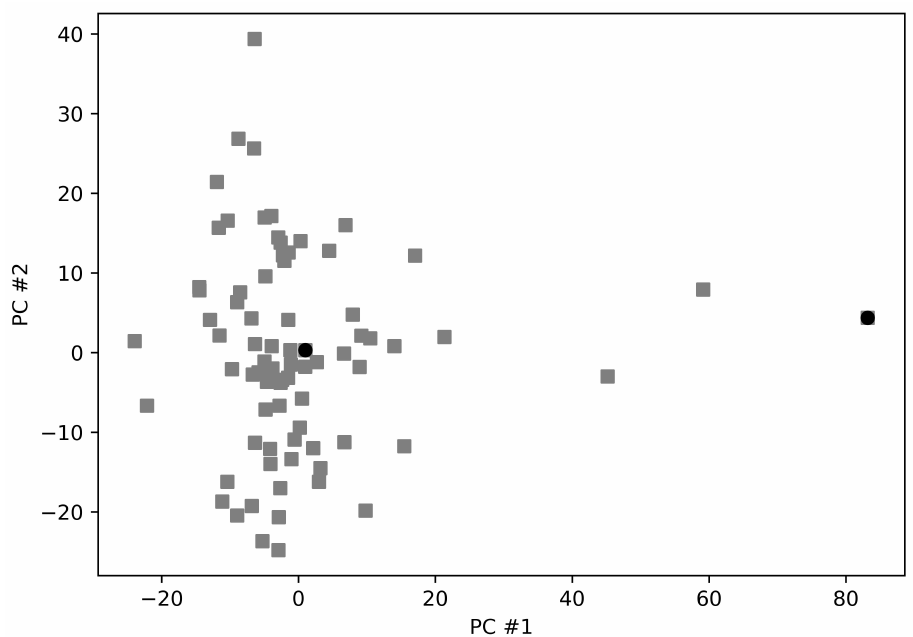
Figure 1. Principal component analysis of the M pro structures used in this work. Black circles represent the position in the plane identified by the first two principal components of 5RET and